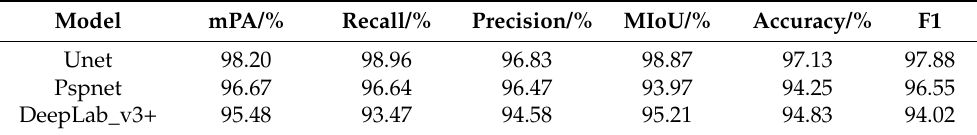
Table 4. The segmentation performance of wood failure areas under different